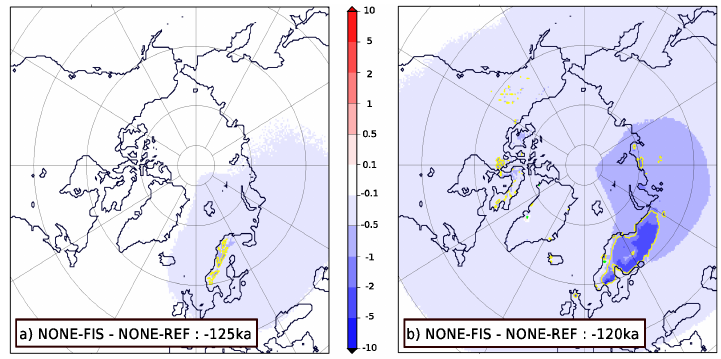
Fig. 5. Summer surface temperature differences between NONE-FIS and NONE-REF at 125ka (a) and 120ka (b) . The yellow line represents the limit where the ice thickness difference exceeds